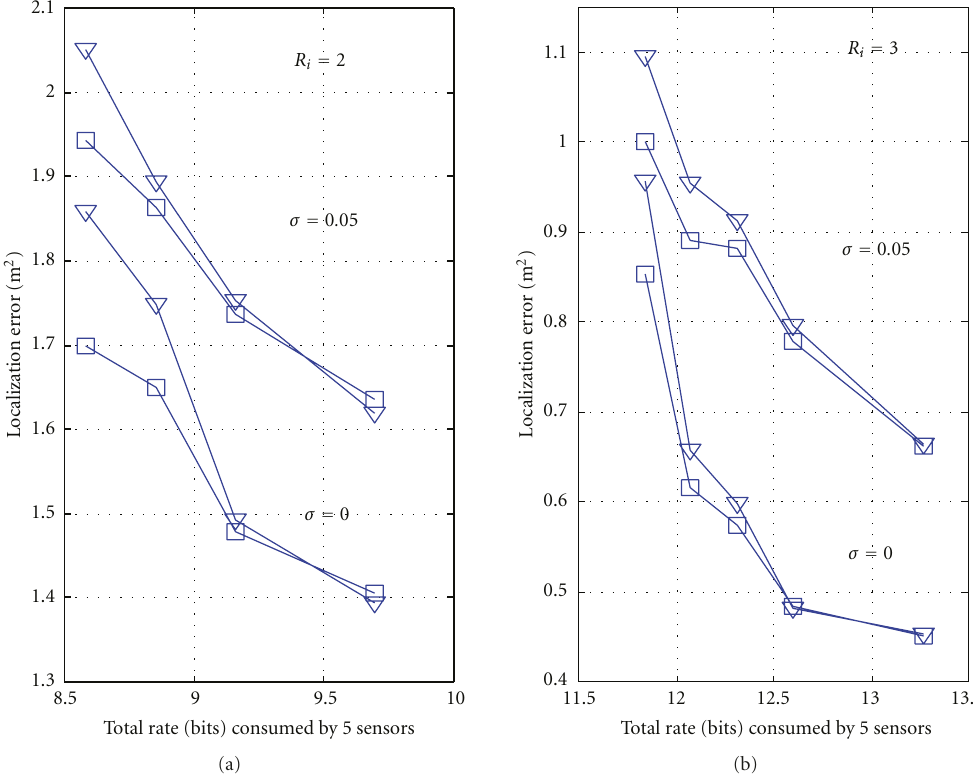
Figure 8: Average localization error versus total rate R M achieved by the distributed encoding algorithm (global merging algorithm) with simple maximum decoding and weighted decoding, respectively. Total rate increases by changing p from 0 . 8 to 0 . 95 and weighted decoding is conducted with L = 2 . Solid line + (cid:2) : weighted decoding. Solid line + ∇ : simple maximum decoding.